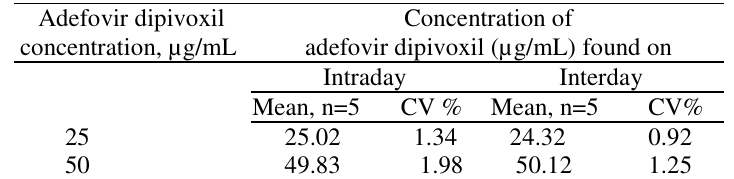
Table 3. Inter and intraday precision for adefovir dipivoxil assay in pharmaceutical dosage forms by the proposed RP-HPLC method.